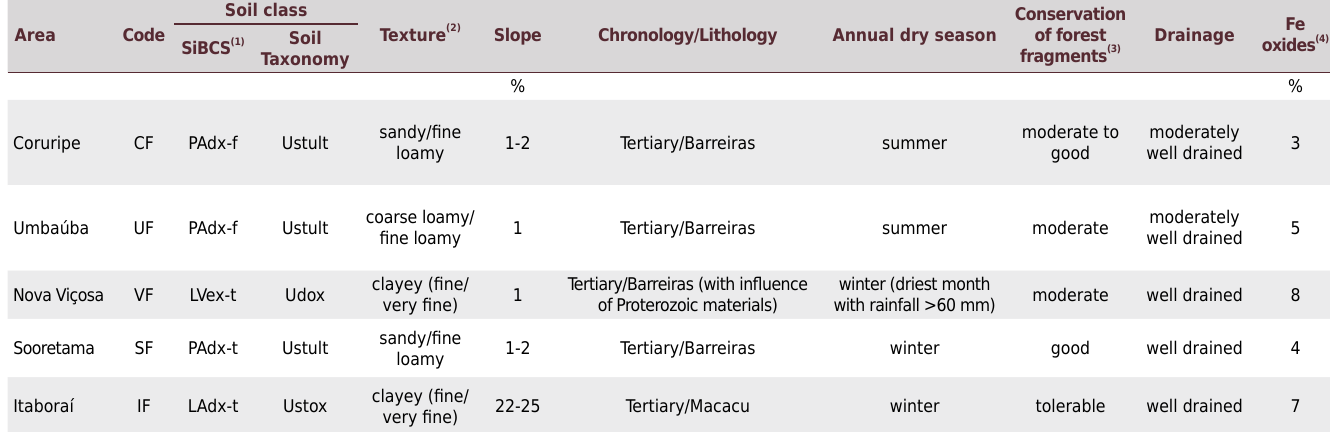
Table 1. Characteristics of forest